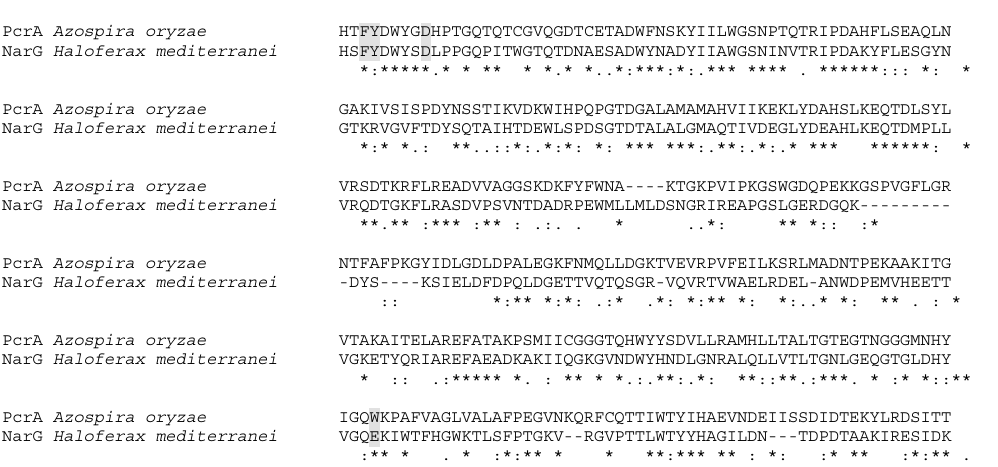
Figure 7. Clustal Omega alignment of all PcrA proteins. Aspartate, which coordinates Mo atom, is in grey. Grey box represents the separate clade of PcrA in which their aspartate is not aligned with the aspartate from the two other groups of PcrA.